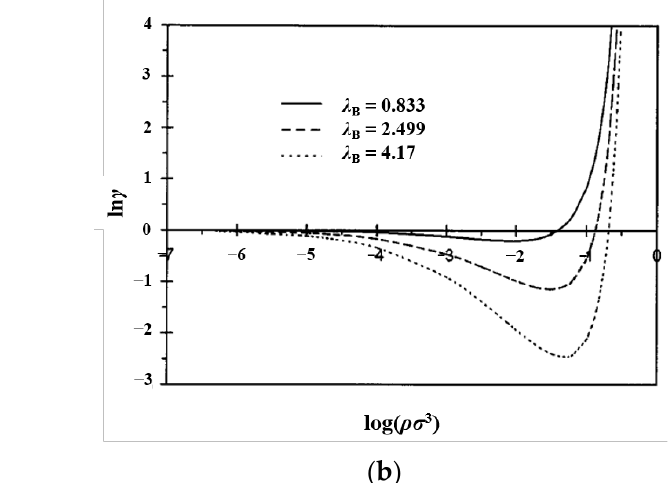
Figure 4. ( a ) Ion activity coefficients for CR61 membrane determined experimentally (filled circles) and calculated by Manning’s model, the additivity rule and Gueron’s model. Reproduced with permission [74]. Copyright 2015, American Chemical Society. ( b ) Mean activity coefficients derived as a function of density for 32-mer chains at different Bjerrum lengths derived from mean spherical approximation. Reproduced with permission [76] . Copyright 1999, AIP Publishing.